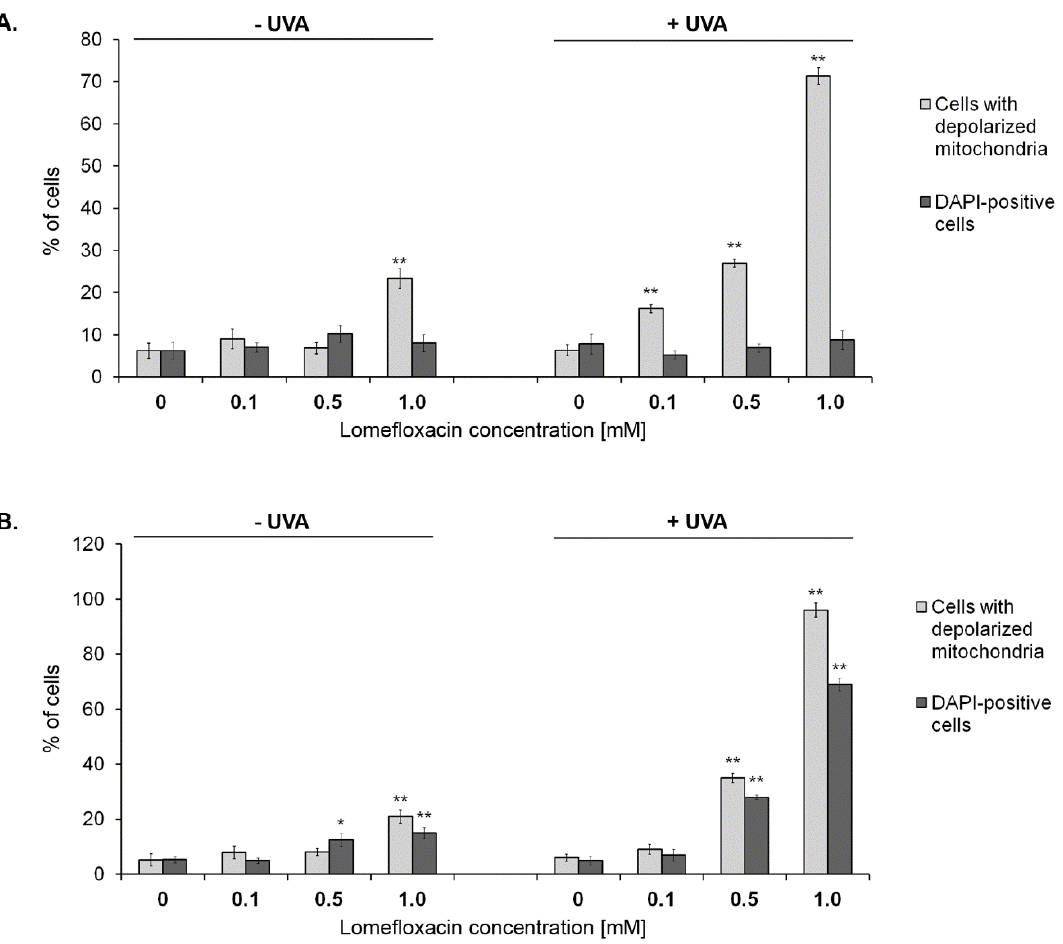
Figure 4. Cytometric analysis of the mitochondrial transmembrane potential disruption in C32 ( A ) and COLO829 ( B ) melanoma cells exposed to lomefloxacin or lomefloxacin in combination with UVA irradiation. The cells were pre-treated with lomefloxacin at concentrations of 0.1, 0.5, and 1.0 mM alone for 24 h or exposed to the drug and UVA irradiation (1.3 J / cm 2 ). Mean values ± SEM from three independent experiments ( n = 9) performed in triplicate are presented. * p < 0.05, ** p < 0.005 vs. control samples. Representative histograms are available in the Supplementary Materials S2.